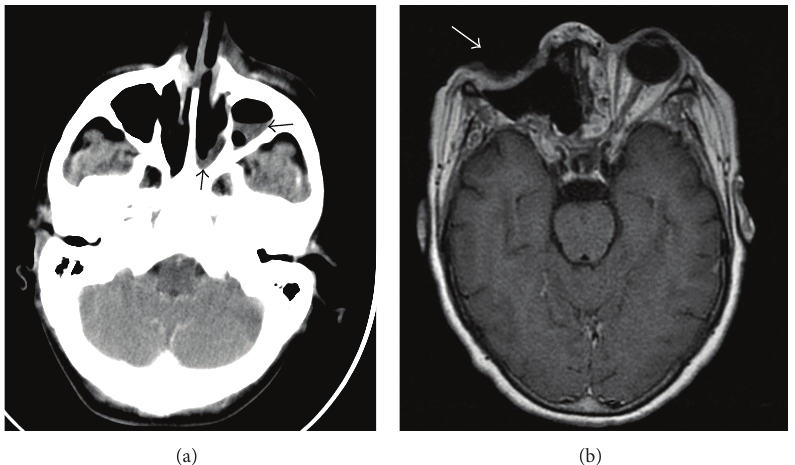
Figure1:(a)Anexampleofacomputedtomographyshowingsinusitis(blackarrows).Biopsieswerepositiveformucormycosisinthispatient. (b) Postsurgical magnetic resonance image (T1 weighted) in a patient with ocular involvement. The patient recovered well.